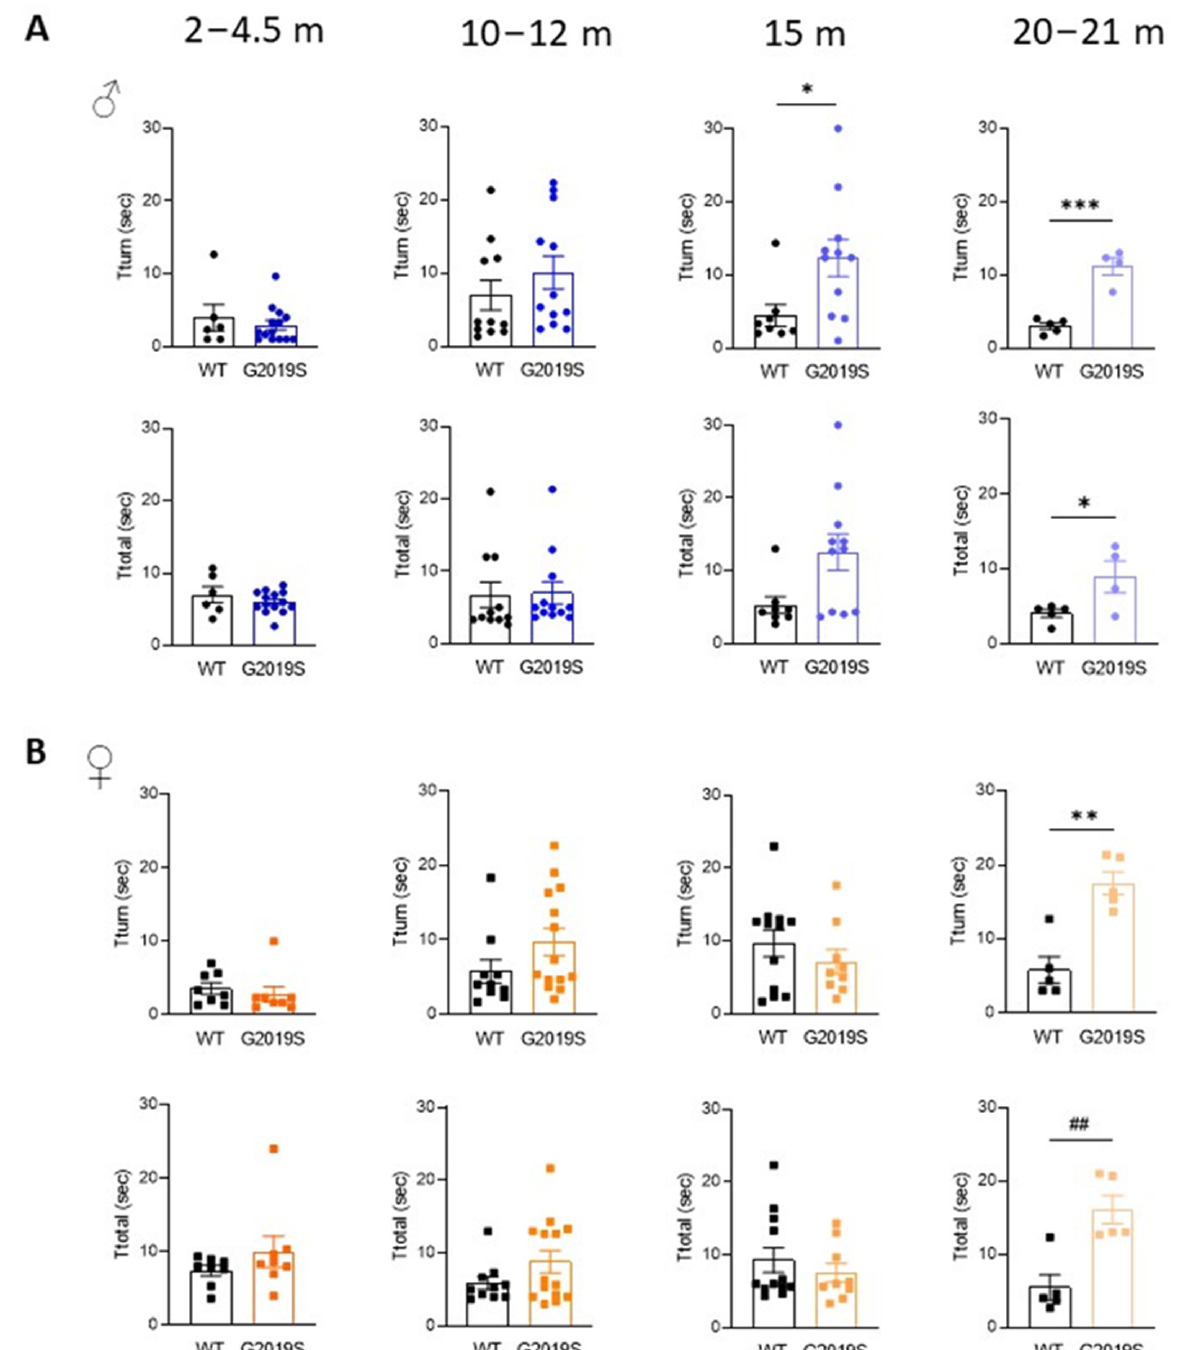
Figure 2. Male and female G2019S mice display fine motor impairment at different ages. Fine motor coordination was assessed with the pole test in male ( A ) and female ( B ) mice at four age ranges. Tturn: time taken by the mice to turn downward from the top of a vertical pole; Ttotal: total time to descend the pole. N = 4–14 mice in each group. * p < 0.05; ** p < 0.01; *** p < 0.001 unpaired Student’s t -test. ## p < 0.01 Mann-Whitney U test.